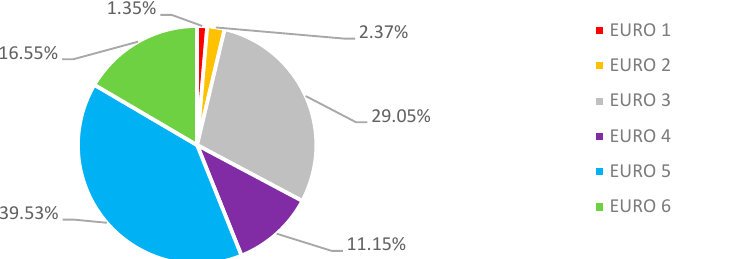
Figure 2. Breakdown of the public bus fleet in Szczecin in 2018 by European exhaust emission standard [%].